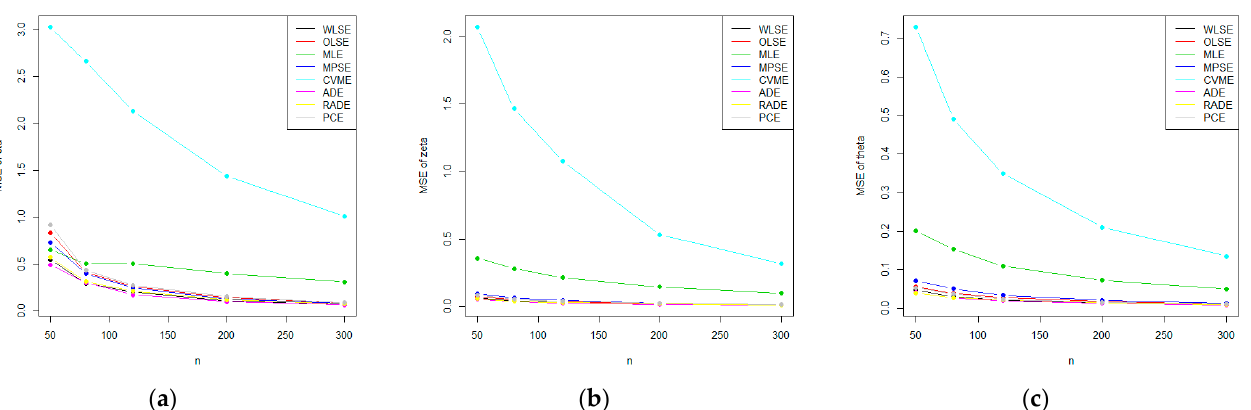
Figure 5. Plots of the mean square errors (MSE) of the E-NPF parameters for the eight methods of estimation using the values in Table 6 ( a – c ).